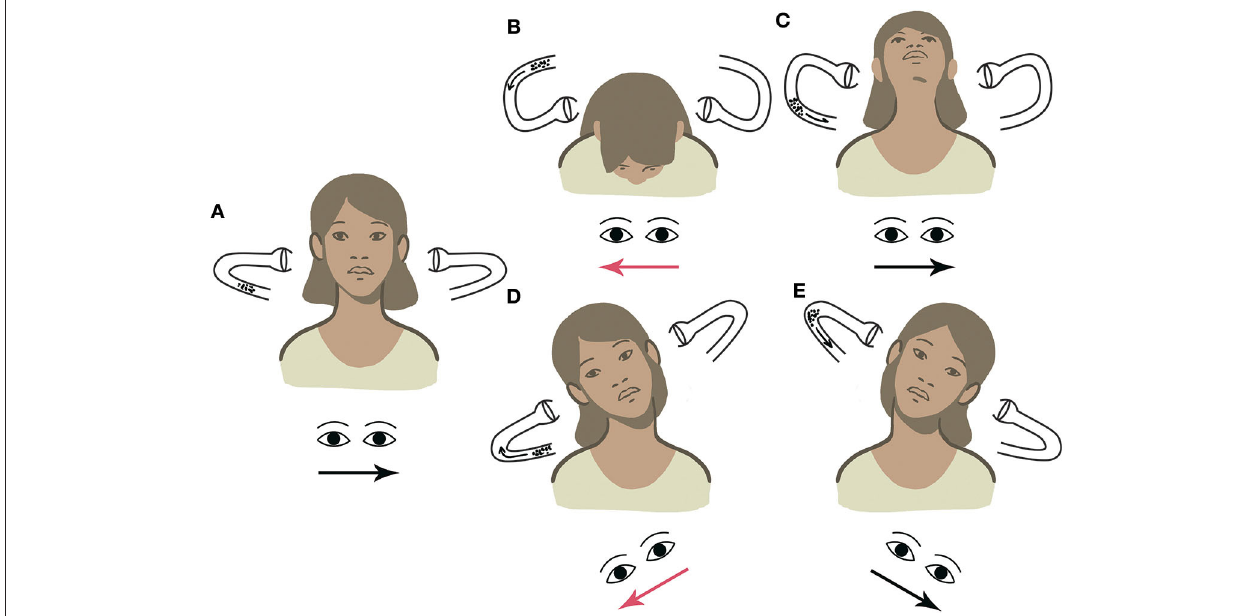
FIGURE 4 | UBP for right geotropic LSC-BPPV. Arrows within the canal represent the direction of endolymphatic flows, whereas arrows beneath the eyes represent the direction of the fast phase of nystagmus. Right-beating nystagmus is represented in red. (A) PSN: left beating. (B) HPT with forward head bending: right-beating